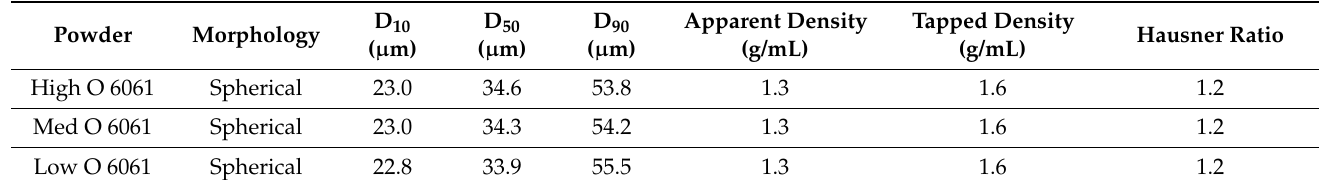
Figure 5. Oxygen content of evaluated aluminum powders.